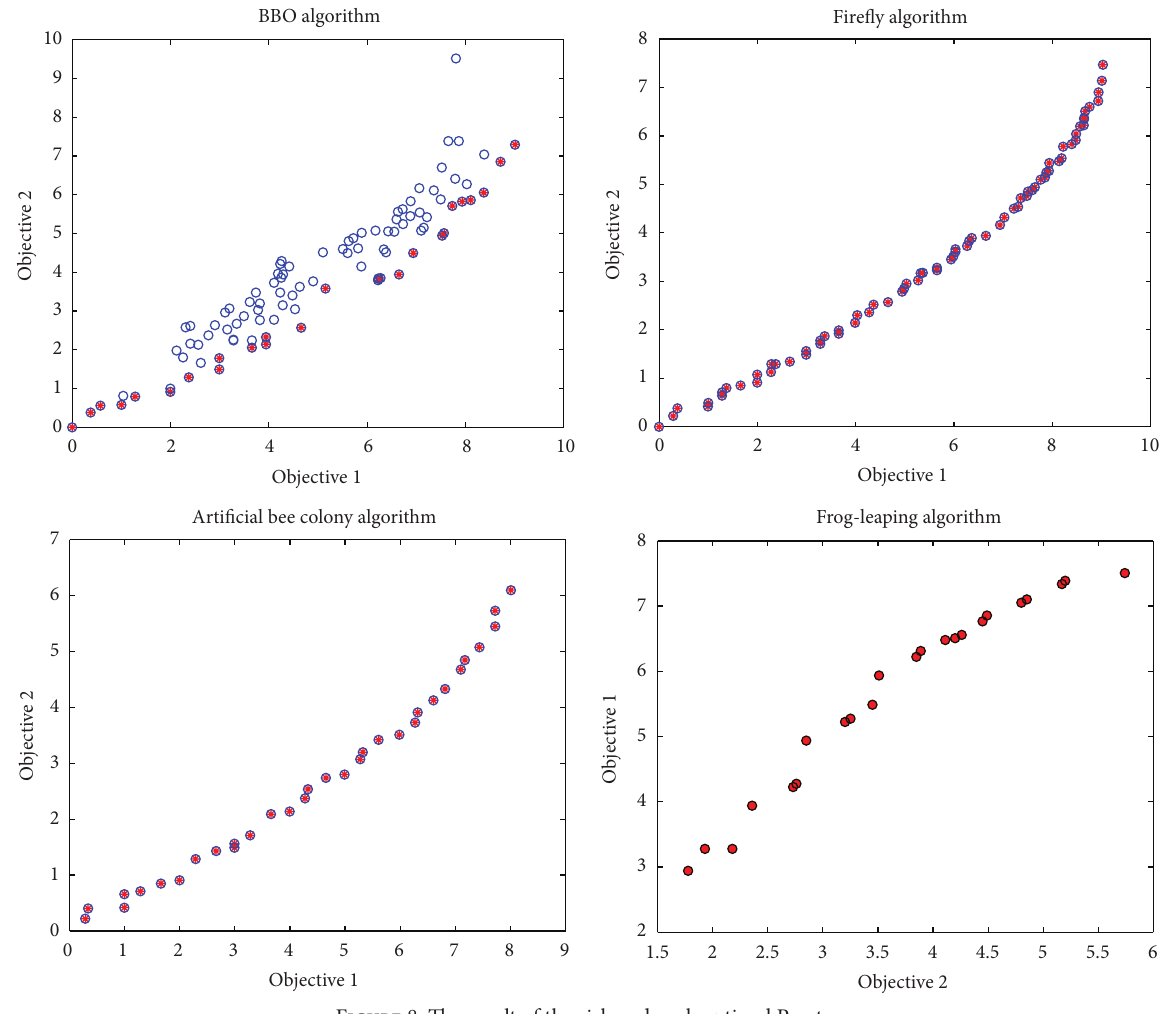
Figure 8: The result of the risk and rank optimal